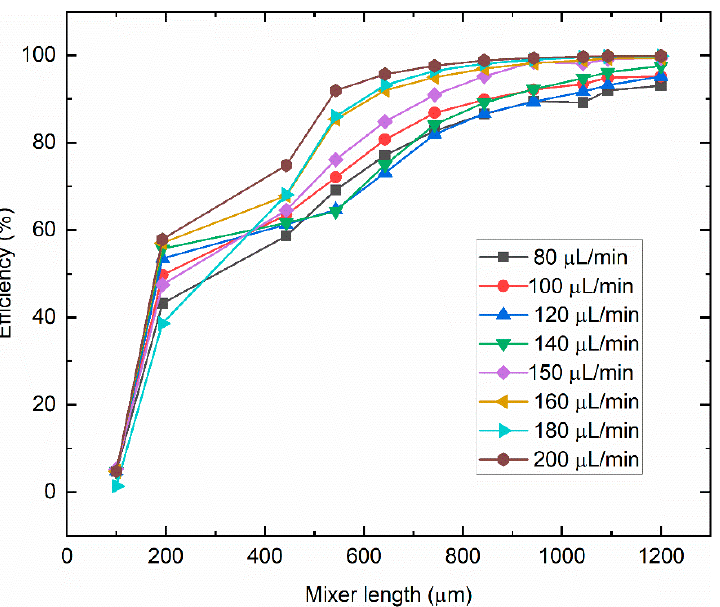
Figure 6. Numerical results: Mixing efficiency as a function of the serpentine mixer length for flow rates in the range of 80–200 µL/min. Within this flow rate range, our 1200 µm long serpentine micromixers can achieve homogenous (>90 %) mixing whilst producing a stable liquid jet for sample delivery at the outlet.